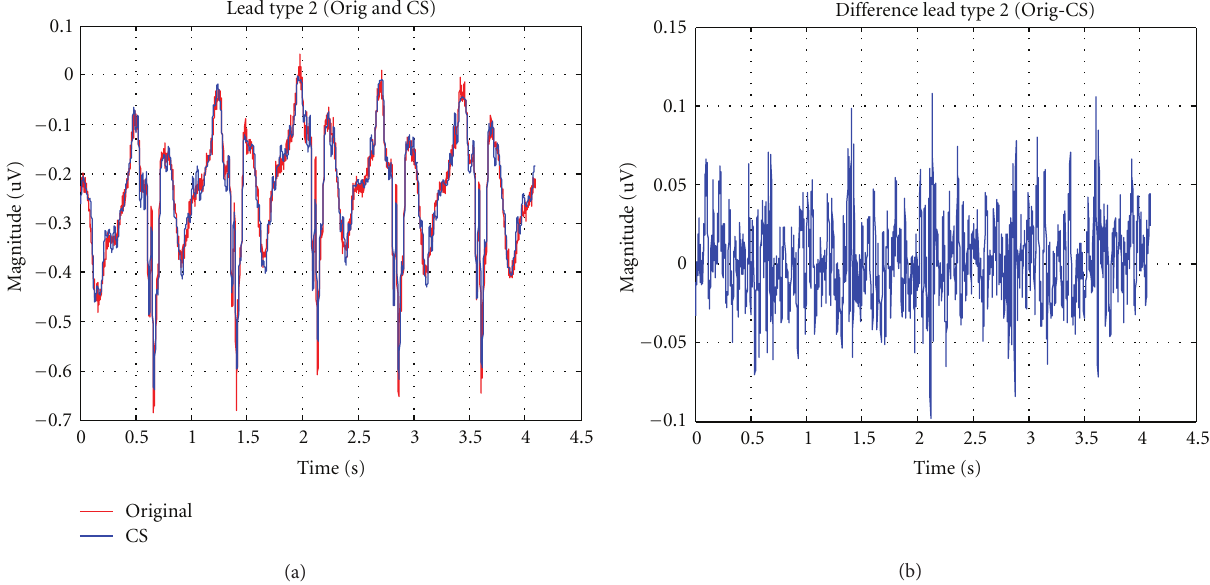
Figure 8: Comparison between the original data and the CS recovering. Figure 8(a) shows lead type 2 at V2, original in blue and the CS in red, where their difference is depicted in Figure 8(a). The difference is less than 0.08 uV.